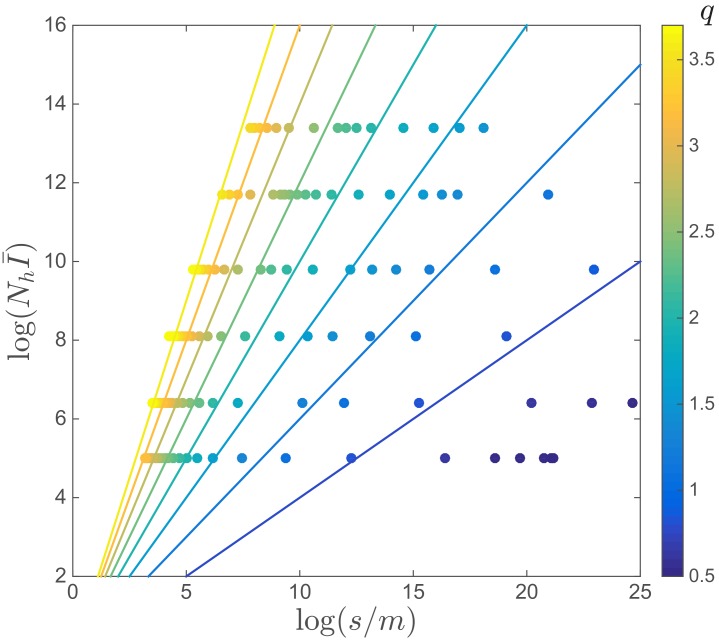
Value of q across the ‘Phase diagram’.This figure shows the same data as one with each data point colored by the corresponding value of q, which is constant along the straight of different angle.